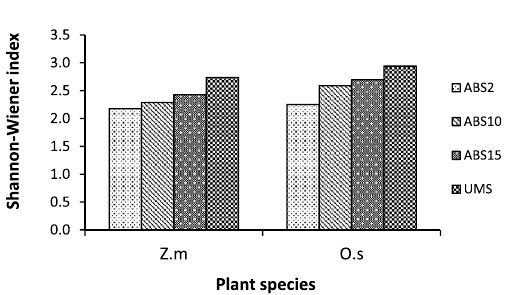
Fig. 3. Shannon-Wiener diversity index in trap culture set up with study sites derived inocula where Zea mays L. (Z.m) and Oryza sativa L. (O.s) are used as trap plants.